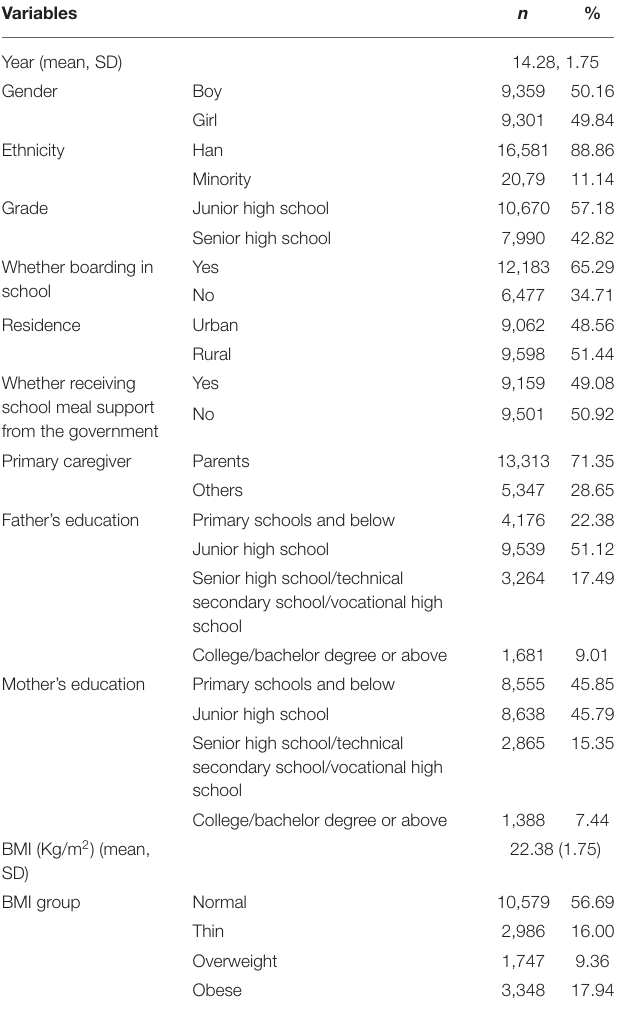
TABLE 1 | Demographic characteristics of students in Chongqing ( N =